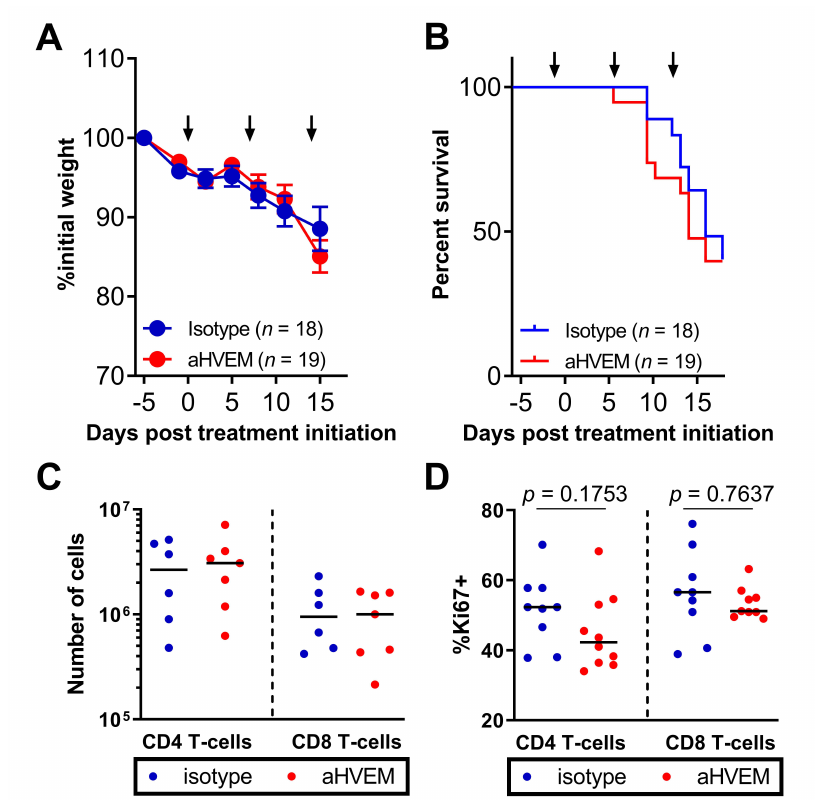
Figure 4. Treatment with the anti-HVEM mAb did not increase GVHD nor the number or proliferation of human T cells in the spleen. Percentages of initial weight ( A ) and survival ( B ) of tumor-bearing humanized NSG mice following treatment by the anti-HVEM mAb or an isotype control are shown. Data shown are cumulative of 3 independent experiments. Numbers ( C ) and frequencies of Ki67 + cells ( D ) at D21 post humanization in the indicated subsets and are cumulative of two independent experiments. Each dot is a mouse. The p -values are from a Mann–Whitney t